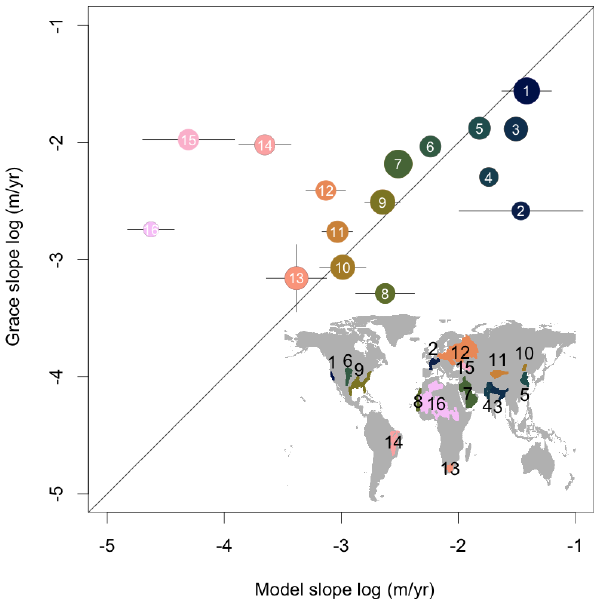
Figure 8. Comparison of depletion rates in Fig. 4a for major groundwater basins with average depletion rates from GRACE (myr − 1 ). The size of the circles is proportional to aquifer area; crosses are standard errors in estimated mean